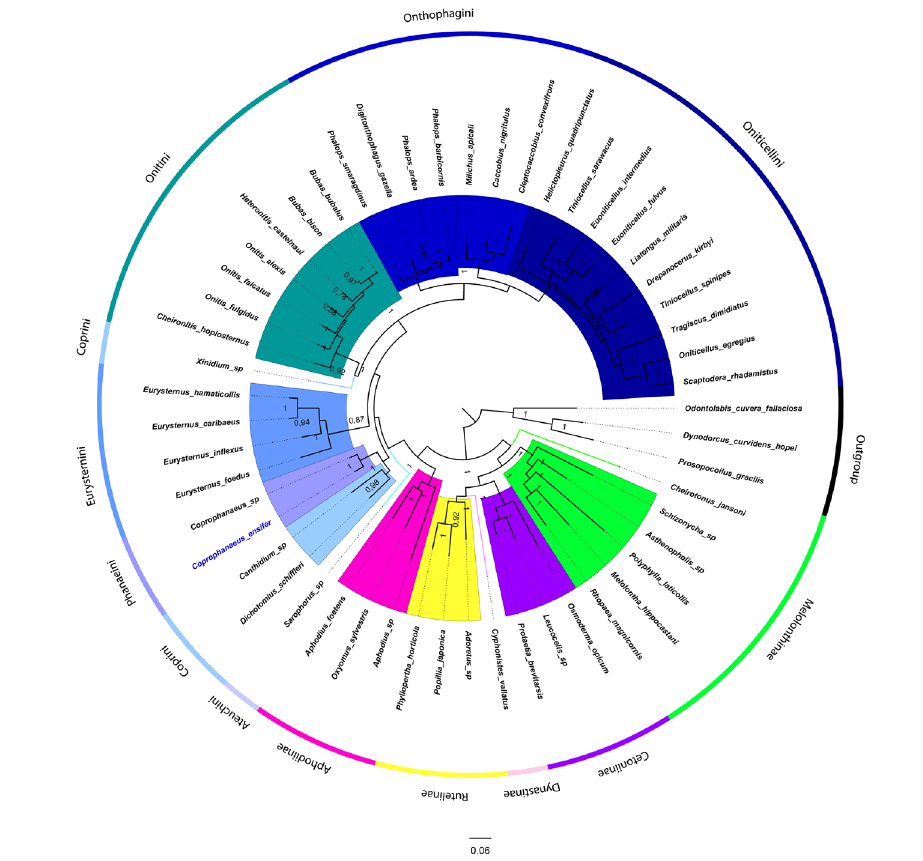
Figure 2. Phylogenetic reconstructions of the family Scarabaeidae based on mitochondrial protein sequences. These reconstructions were performed by Bayesian inference using the MtREV G+I+F substitution model. The colors of each clade distinguish the Scarabaeidae subfamilies as well as Scarabaeinae tribes. Coprophanaeus ensifer is highlighted in blue in the